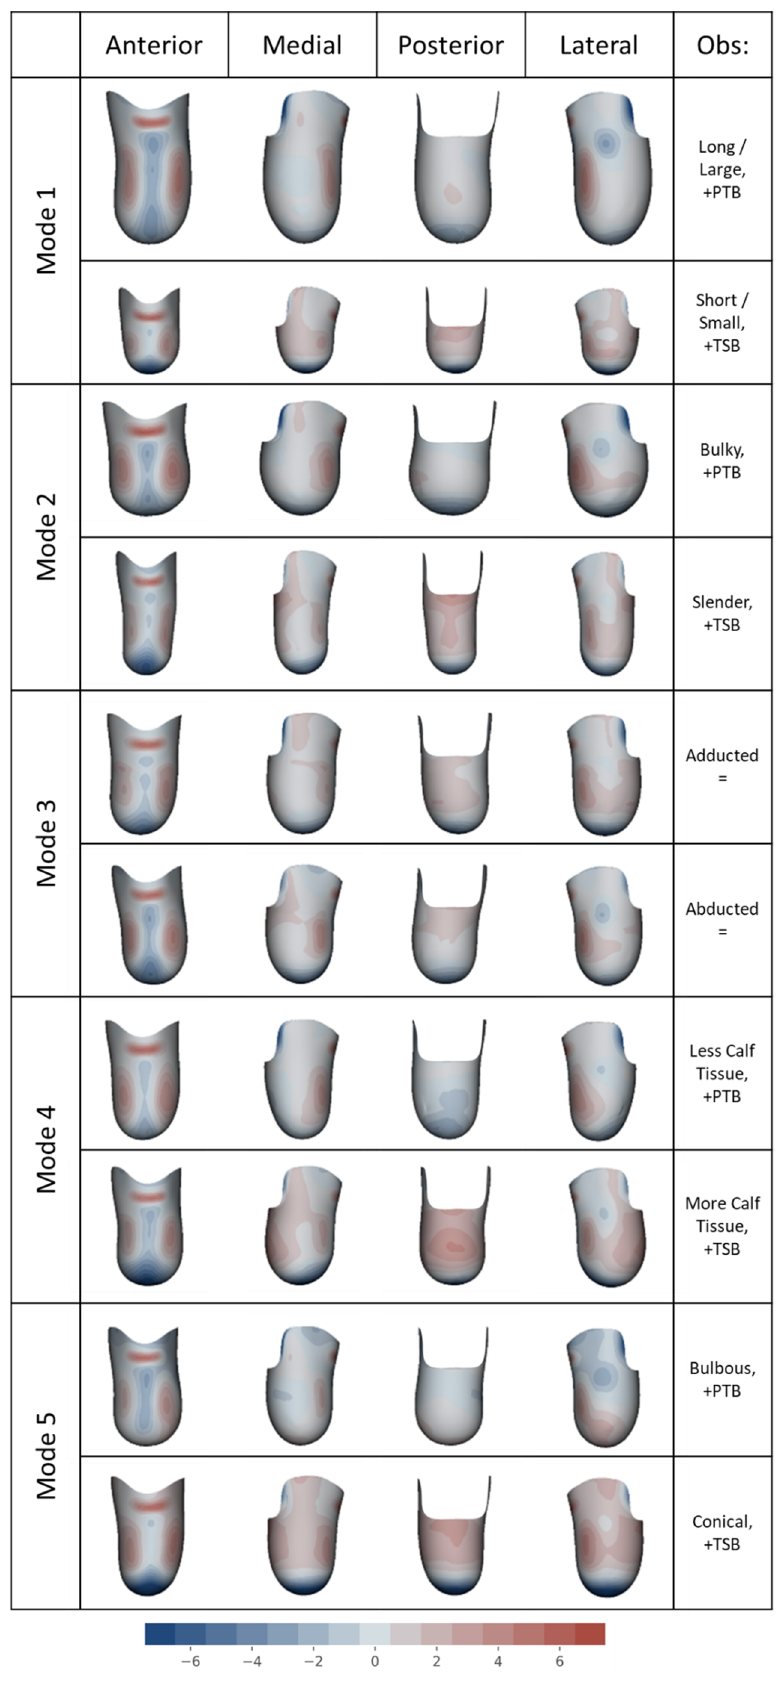
Figure 7. First five mode variations for the statistical limb shape and socket design model (SLDM), showing mean ±2 standard deviation shapes. Rectification map units: mm.